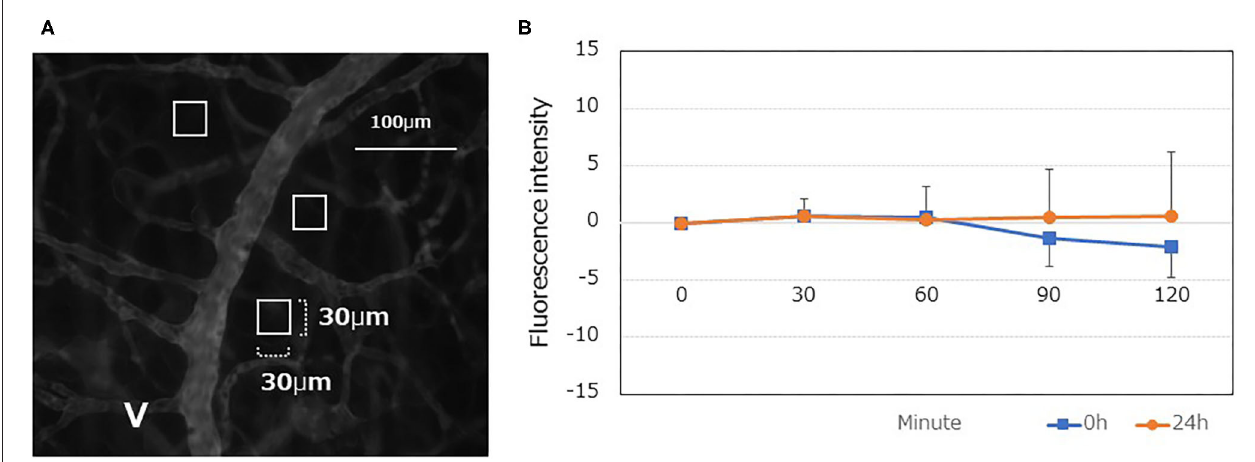
FIGURE 5 | Quantitative analyses of the vascular permeability of TMR-dex75 at 0, and 24h after LPS administration. (A) Typical fluorescent gray image following TMR-75 administration (0min). Interstitial tissue containing as few capillary blood vessels as possible was randomly selected, and a square region of interest (ROI) was set at three locations (30 × 30 µ m each). The mean fluorescence intensity within the ROI was calculated using ImageJ. The ROI was followed up at 30, 60, 90, and 120min to determine the fluorescence intensity of the interstitial tissue. (B) A time-dependent increase was not observed even at 24h after LPS administration ( n =